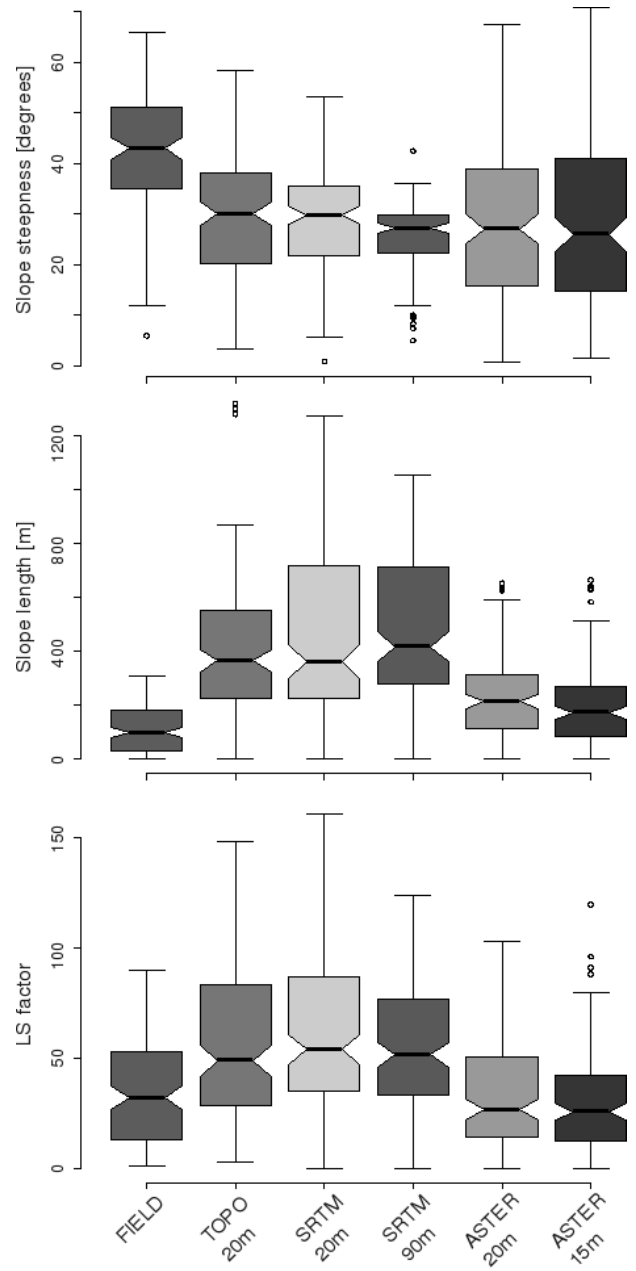
Figure 7. Boxplots comparing the field measured and DEM derived slope steepnesses, slope lengths and RUSLE LS factors at 152 locations.